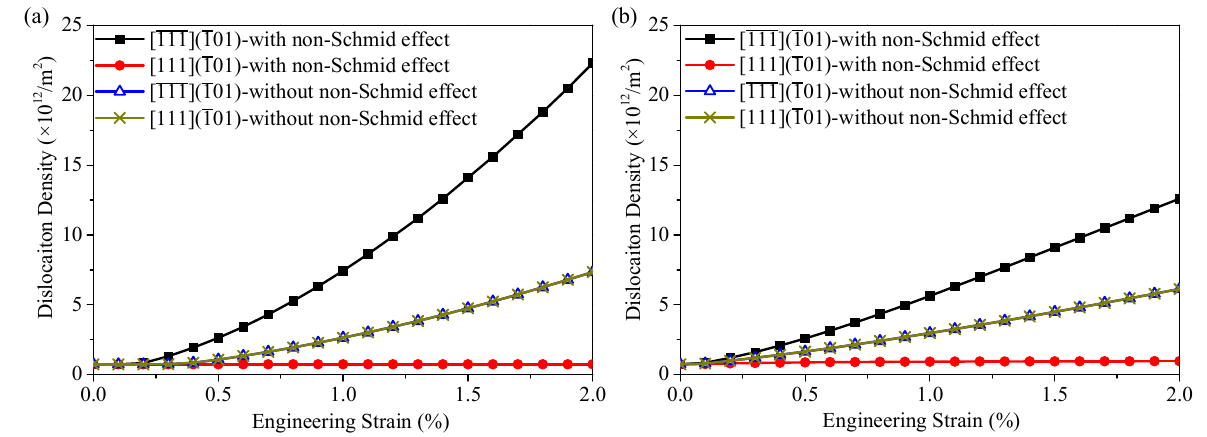
Figure 2. The NS effect on the dislocation density evolution of two typical slip systems at two different temperatures of ( a ) 295 K and ( b ) 573 K.